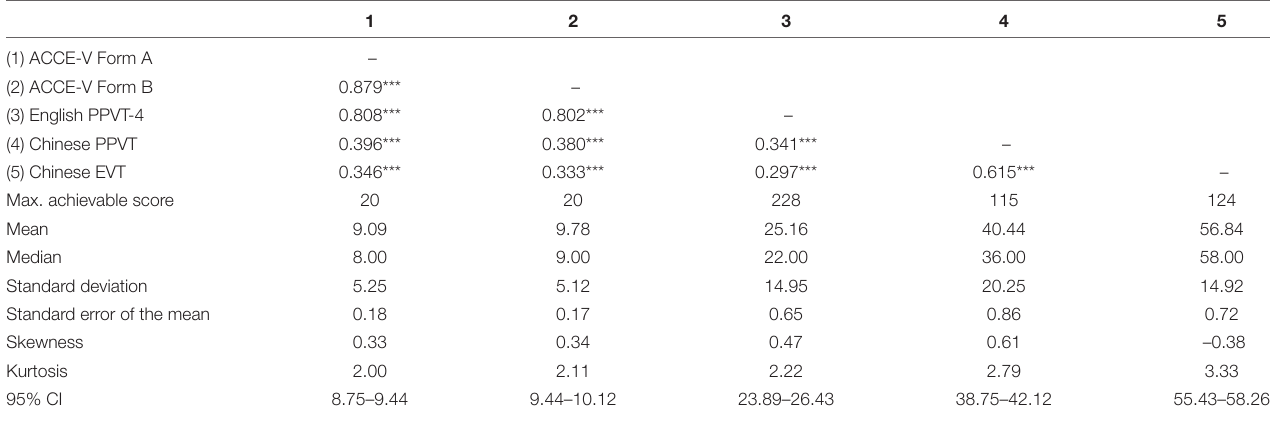
TABLE 5 | Correlations and descriptive statistics for the five tests (ACCE-V Form A, ACCE-V Form B, PPVT-4, and PPVT-C).